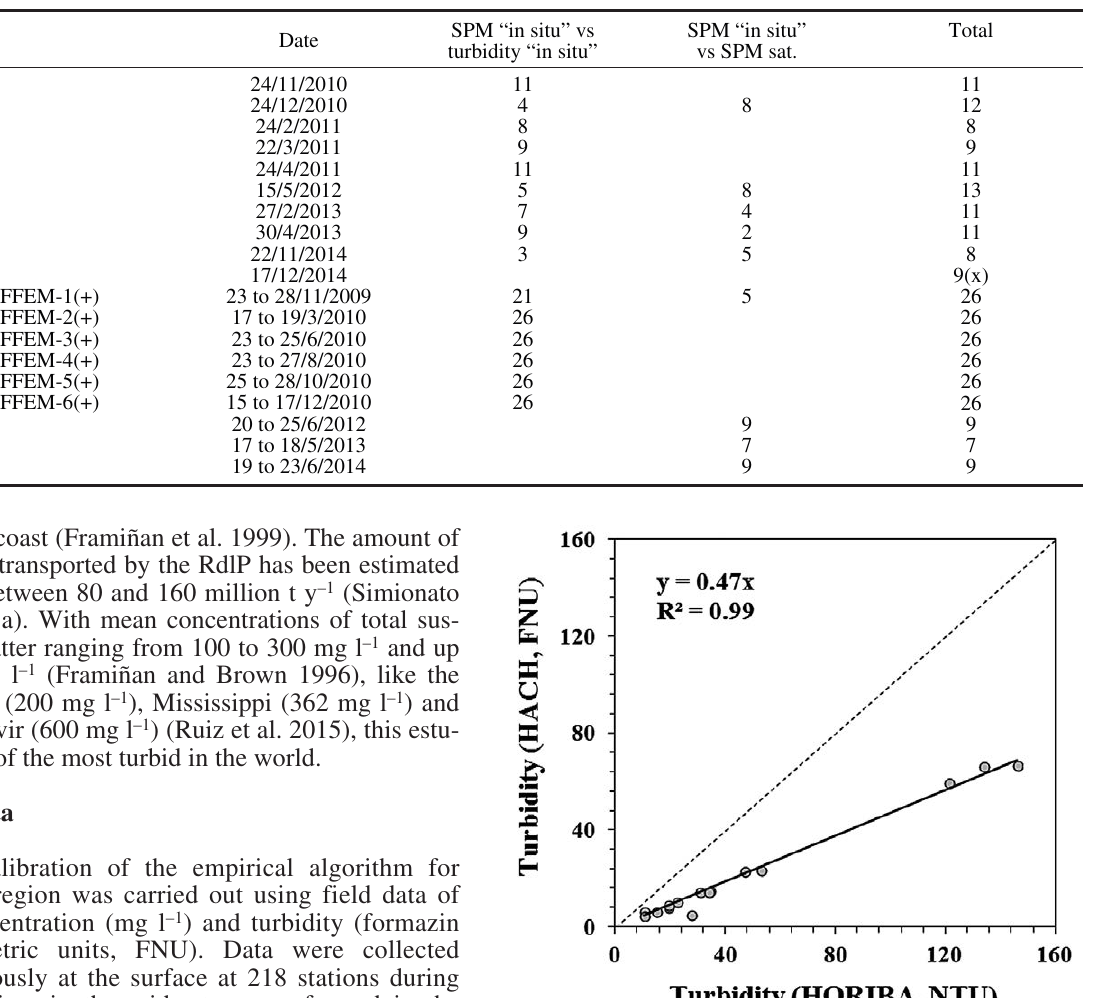
Table 1. – Number of samples collected between 2010 and 2014, used to find the relation between a) in situ SPM and in situ turbidity, and b) in situ vs satellite-derived (sat) SPM. (x) Only turbidity data were measured. (*) HORIBA U-22XD turbidimeter. (+) HACH 2100P ISO turbidimeter. RdlP: Río de la Plata.